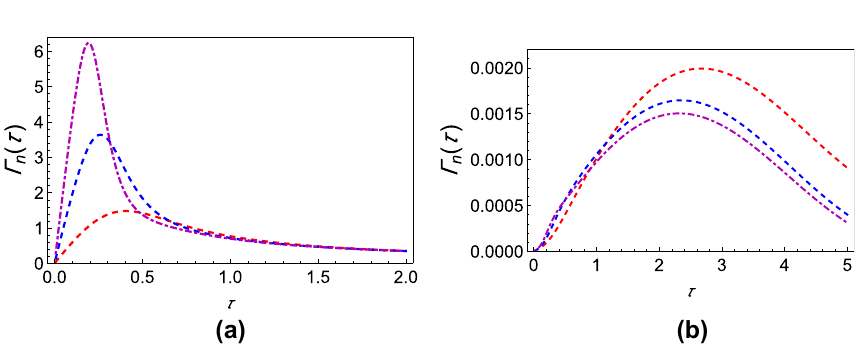
Figure 6. Variation of the modified decay rate with the system–environment coupling strength. ( a ) Graph of Ŵ n (τ) as a function of the measurement interval τ for θ strengths. ( b ) Graph of Ŵ n (τ) as a function of τ for θ parameters used in ( a ) and ( b ) are the same as Fig. 1, except that we are now showing the modified decay